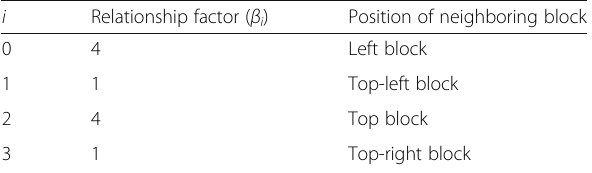
Table 6 Relationship factor ( β i ) and position of